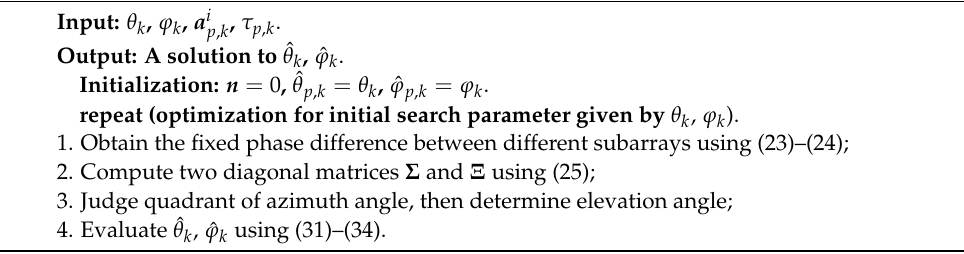
Algorithm 2: Decoupling of elevation and azimuth